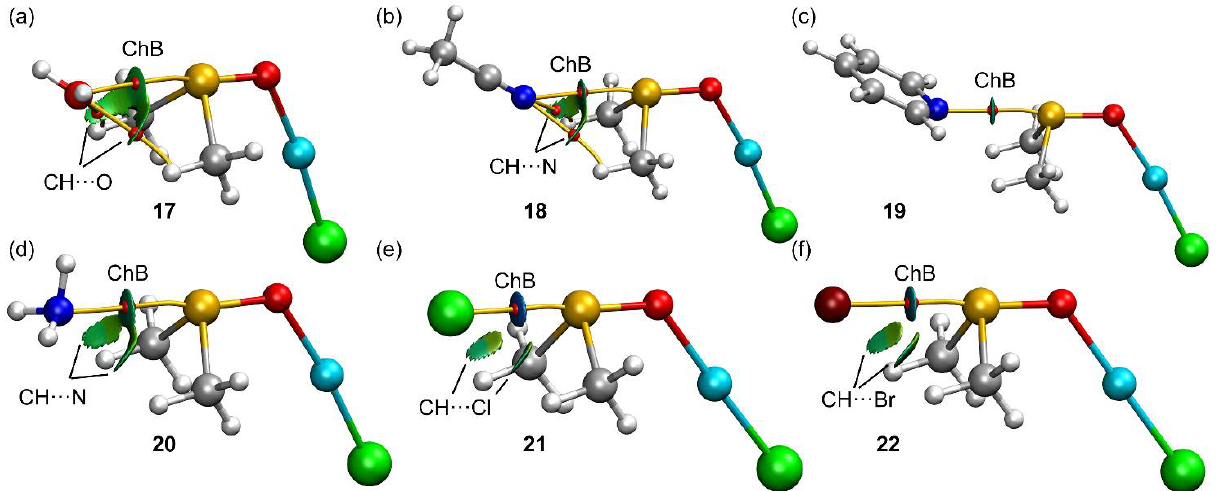
Figure 7. Combined QTAIM (bond critical points as red spheres and bond paths as yellow lines) and NCIPlot analyses of complexes 17 ( a ), 18 ( b ), 19 ( c ), 20 ( d ), 21 ( e ), and 22 ( f ) at the PBE0-D3/def2-TZVP level of theory. Only intermolecular interactions are represented.